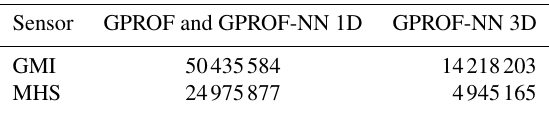
Table 3. Number of pixels with precipitation information in the test datasets used to evaluate the